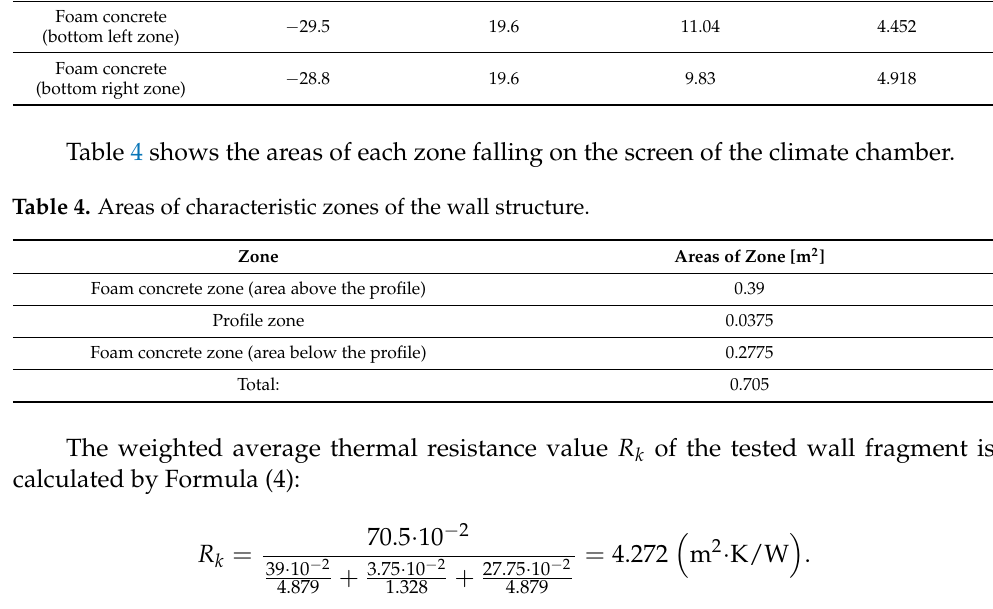
Figure 11. Heat flow dependence on time.